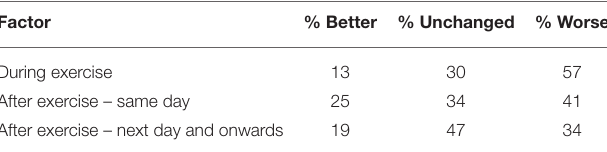
TABLE 4 | Dystonia symptom behavior during and after exercise in the short and long term. Factor